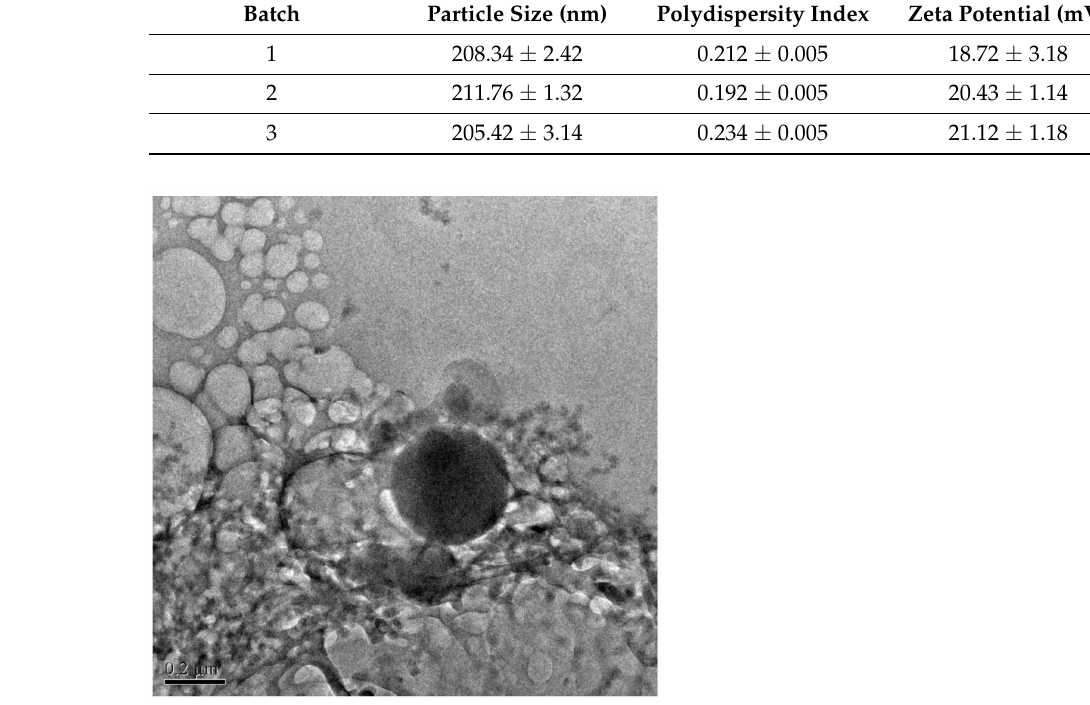
Figure 4. TEM image of ibrutinib